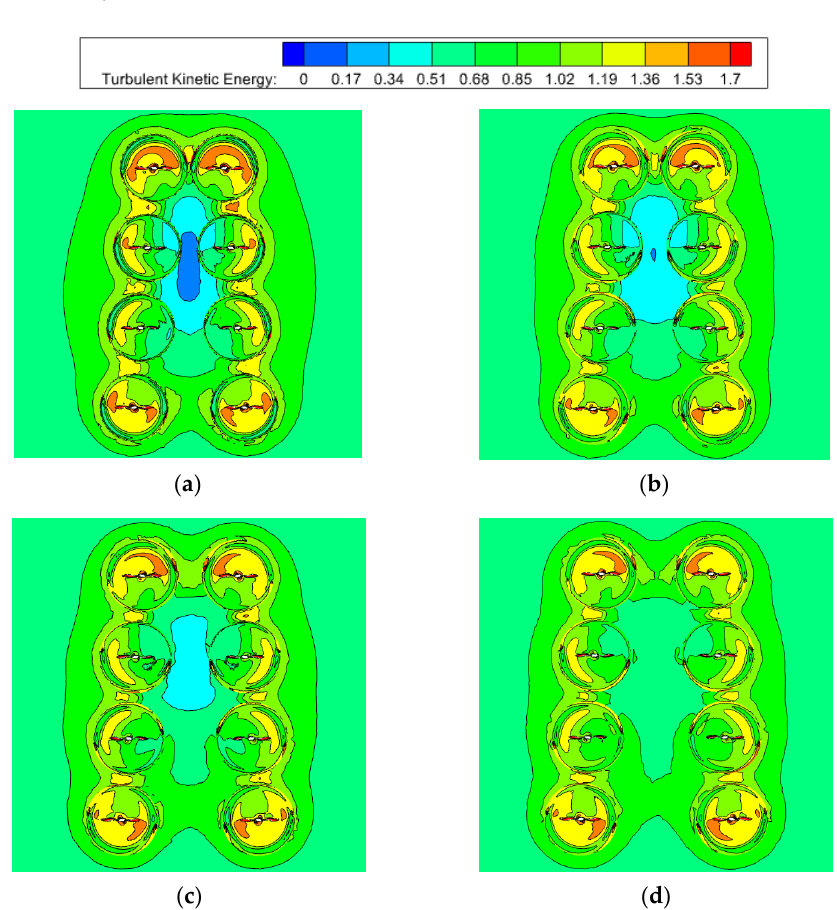
Figure 14. Turbulent kinetic energy distribution. ( a ) Group 1; ( b ) Group 3; ( c ) Group 5; ( d ) Group 7.